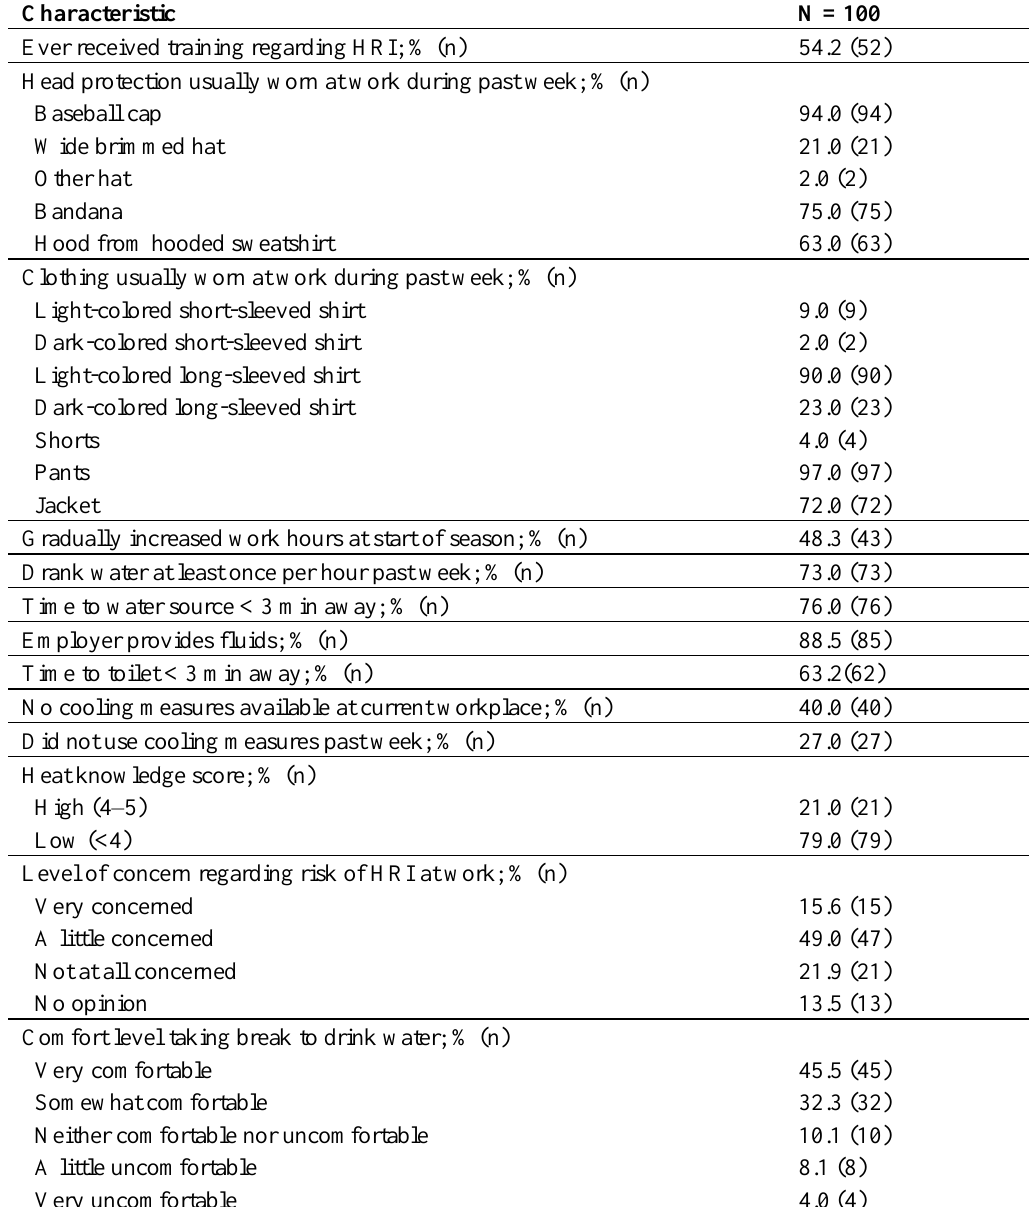
Table 3. Heat-related illness knowledge and practices among study participants, Oregon,